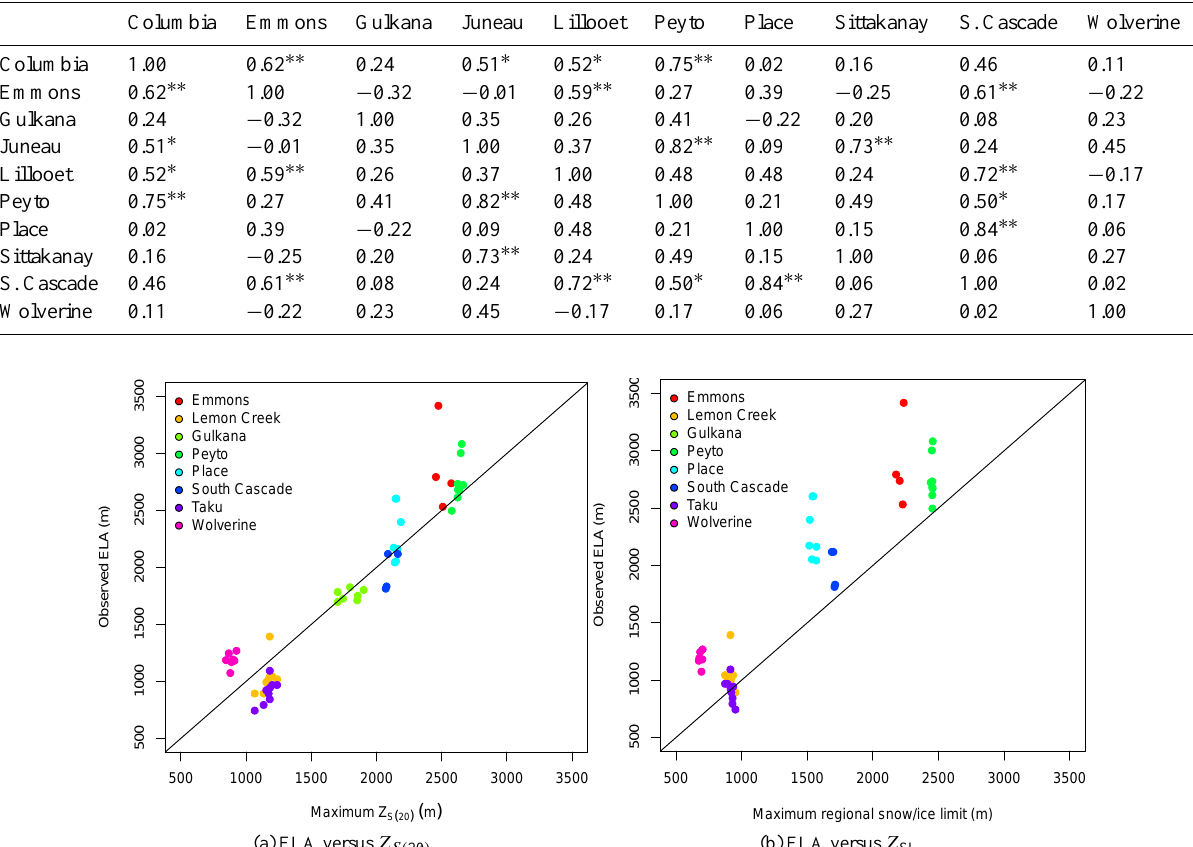
Fig. 10: Index glacier ELAs observed from field data versus (a) maximum regional Z S( 20 ) and (b) maximum regional Z SL , 2000–2009. Table 7. Geodetic and ELA estimates of glacier mass change (inGt), for Columbia, Lillooet, and Sittakanay